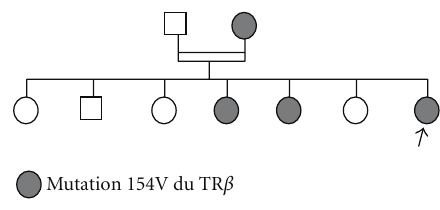
Figure 2: Pedigree of the